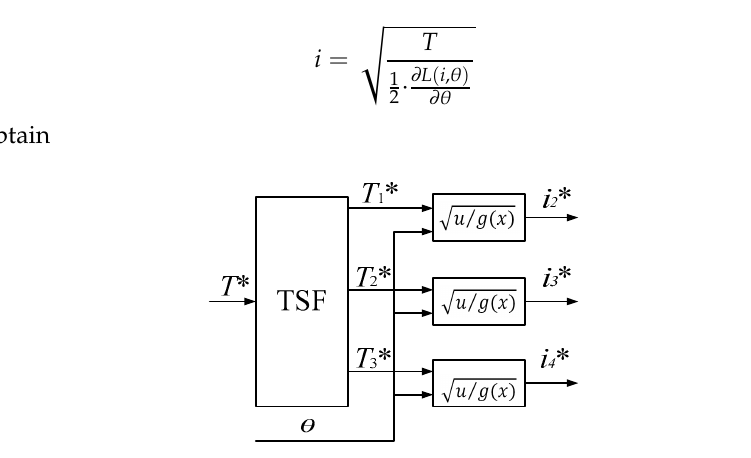
Figure 10. Control scheme of the RotLin motor.